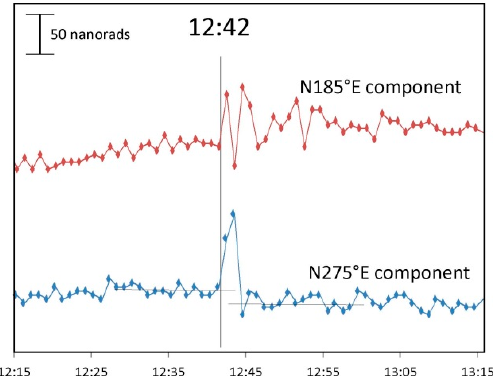
Figure 6. Tilt data recorded at the two components of TDF station between 12:15 and 13:15 UTC on 1 December 2017. Tilt sampling is one minute, and each value is the average of 8000 samples. Remote Sens. 2019 , 11 , x FOR PEER REVIEW